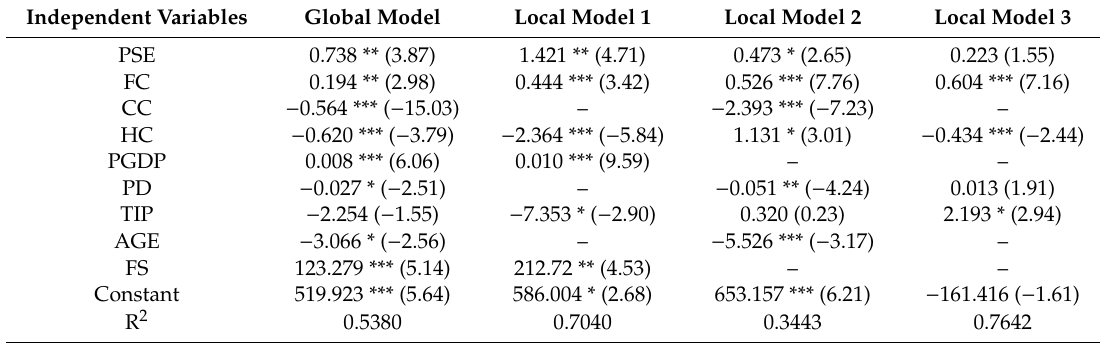
Table 6. Statistic results of the global model and local models.